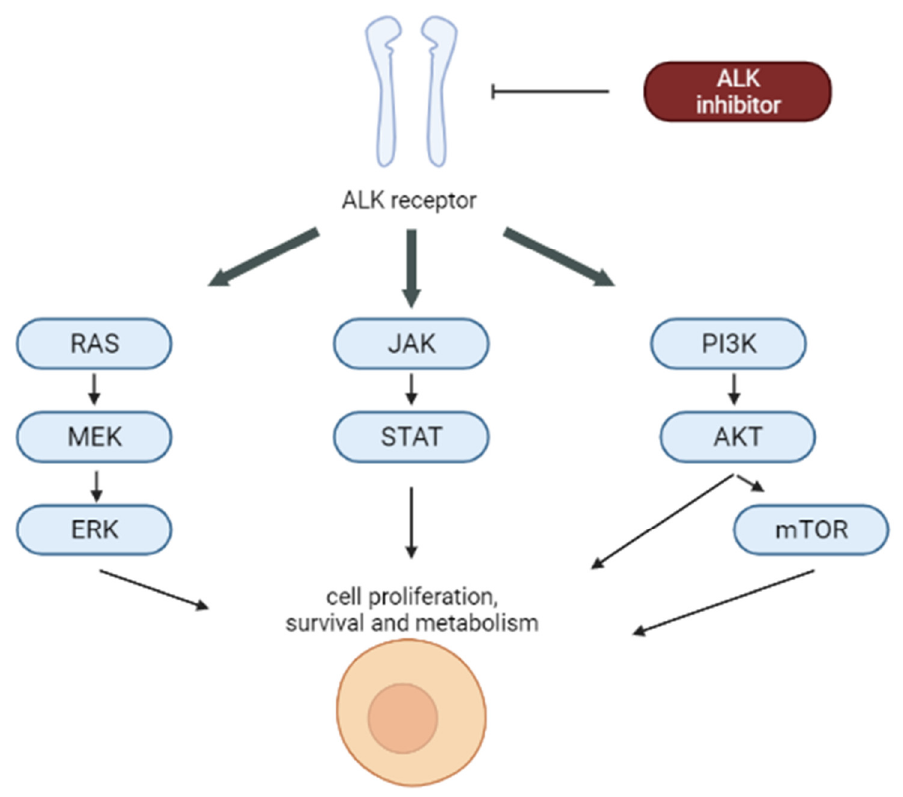
Figure 5. Signalling pathways blocked by ALK inhibitors.